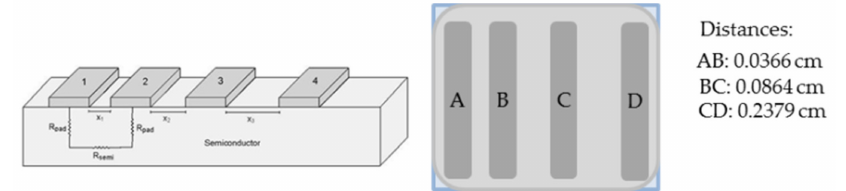
Figure 2. Schematic of the transmission line model (TLM) structure used to measure the electrical parameters of the fabricated